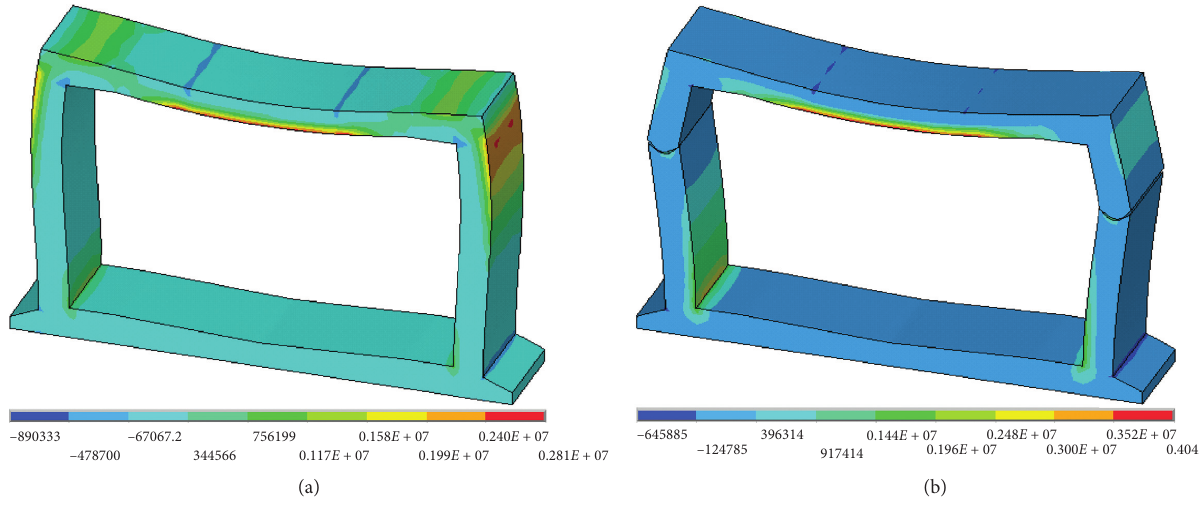
Figure 14: The first principal stress cloud diagram of the concrete. (a) Integral BC. (b) Round hinged